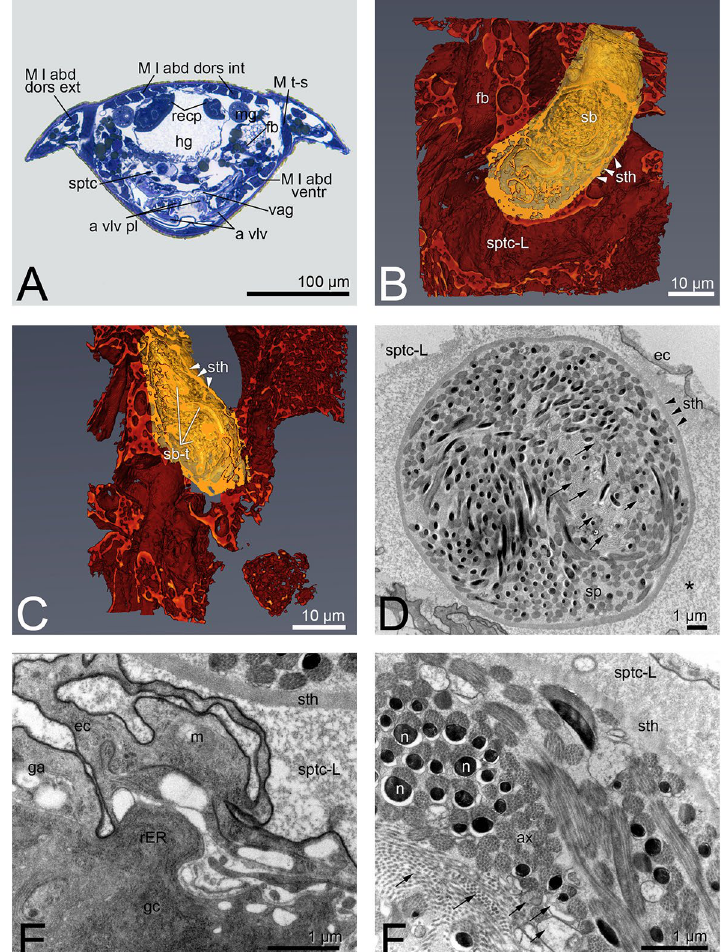
Figure 4. Hercinothrips femoralis , ( A ) location relationship of the spermatheca within the body cavity, transverse section; ( B ) spermatheca filled with a sperm ball of compressed secretion and spermatozoa, nano CT; ( C ) spermatheca filled with a sperm ball with several tubes; ( D ) sperm ball within the secretion-filled spermatheca; ( E ): epithelial layer of the spermatheca; ( F ) ultrastructure of defective and intact spermatozoa within the sperm